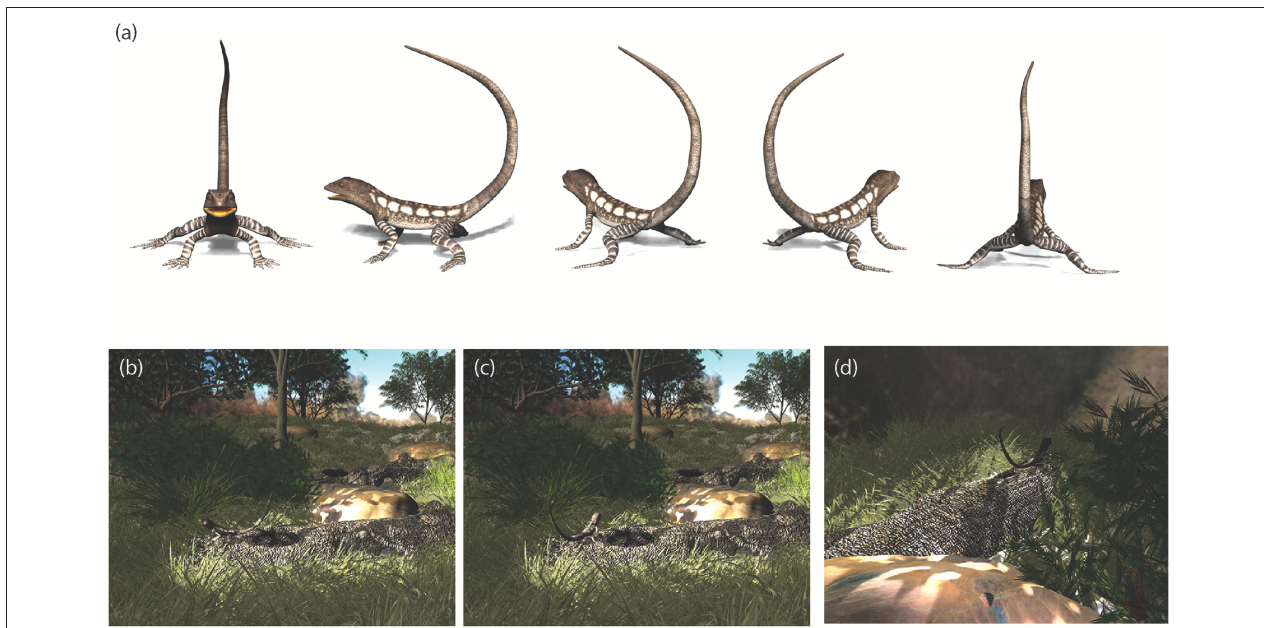
FIGURE 4 | We manipulated the position of the lizard in the scene to examine whether signal effectiveness is mediated by signaler orientation. (a) Five different orientations were considered: front-on, side-on, angled left, angled right and from behind (back), respectively, from left to right. (b) We chose to change the orientation of the signaler rather than position of the viewer (camera position) as the latter includes concomitant changes in the background. For example, differences in signal effectiveness between the lizard in (b) and (c) under identical plant movements is attributable to the change in signaler orientation. However, the effect of changing orientation when comparing (b) and (d) is confounded by the very different plant movement